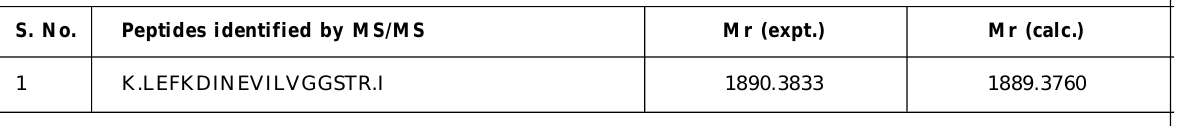
Table 4D: The MALDI TOF mass spectrum sequence of peptides matched with gi|302764140 hypothetical protein SELMODRAFT_230659 Selaginella moellendorffii (Protein score: 51) S.